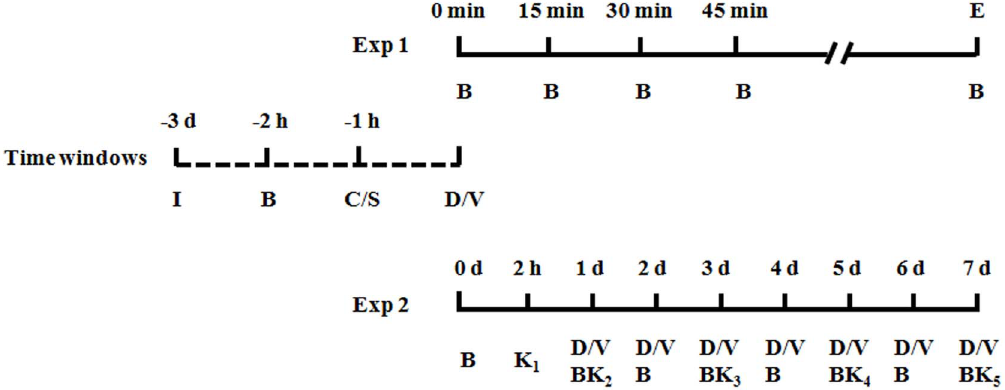
Figure 1. Experimental protocol. Time window indicated the days after s.c. CFA or saline injection. I: Intrathecal catheter implantation; B: Behavior test; C: CFA subcutaneous injection; S: Saline subcutaneous injection ; D: Drugs intrathecal injection; V: Vehicle intrathecal injection; E: End of the effect of i.t. medication; K: Killing the rats for further immunofluorescence histochemical staining, western blot, and HE staining.